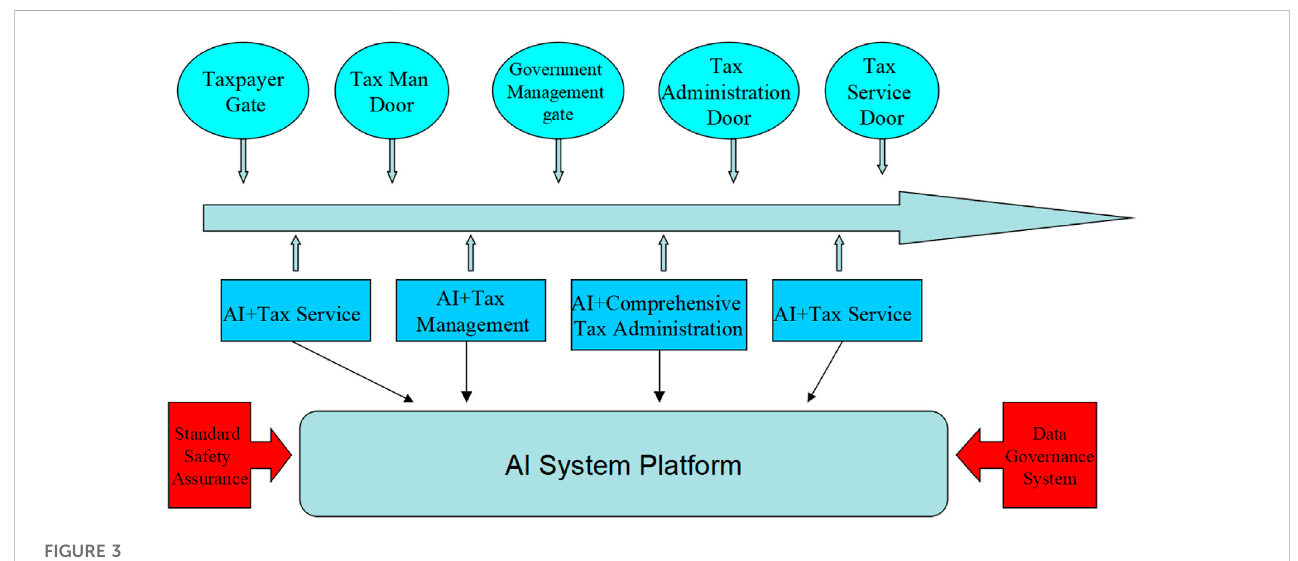
FIGURE 3 Environmental protection tax information construction